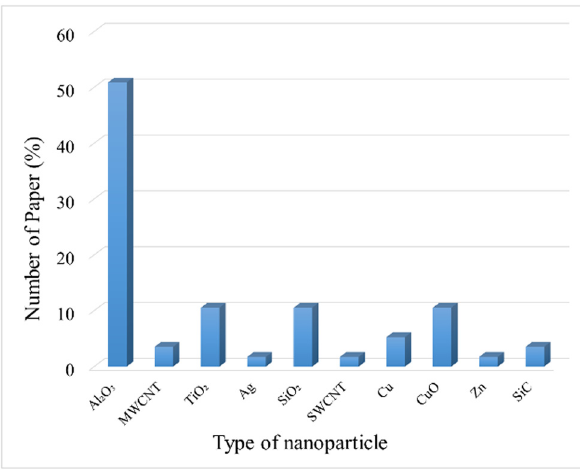
Figure 4: Type of nanoparticles commonly used in nano fl uid preparation.